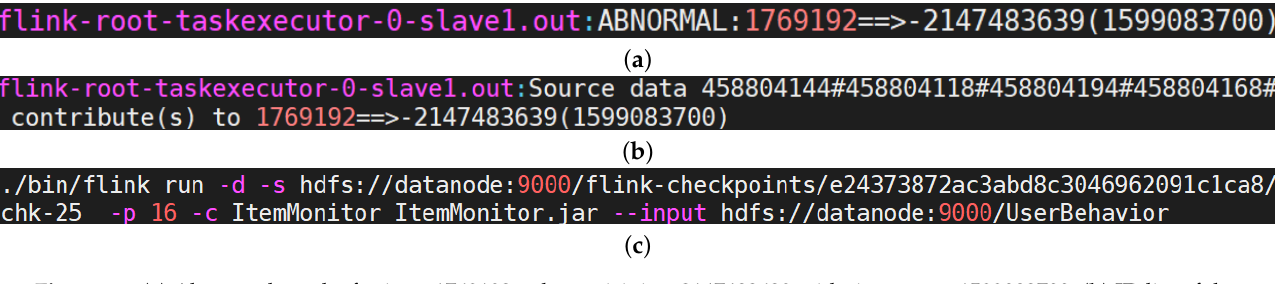
Figure 16. ( a ) Abnormal results for item 1769192, whose visit is − 2147483639 with timestamp 1599083700; ( b ) ID list of the source data that contribute to the result; ( c ) restart the job from a specific checkpoint. Table 5. Source IDs with their corresponding source data and the latest checkpoint before the source data are